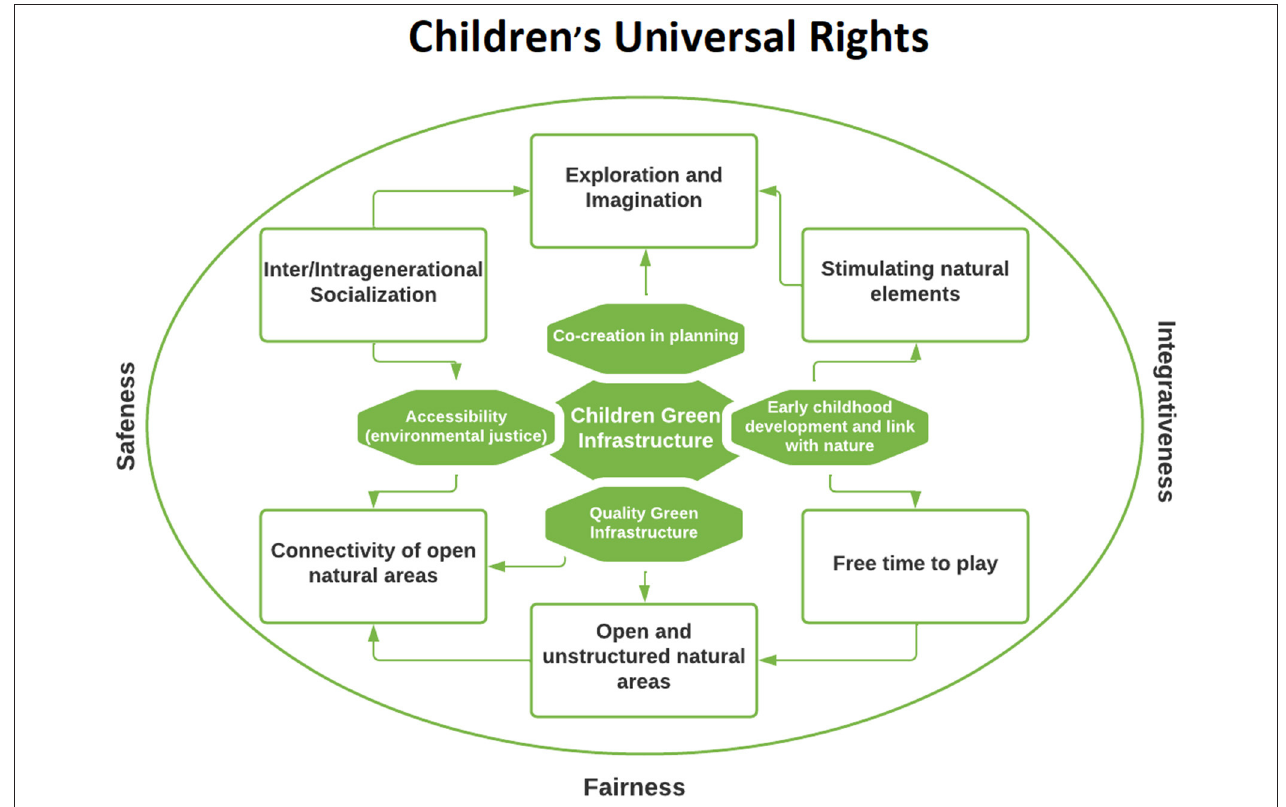
FIGURE 1 | Children green infrastructure model proposed by the